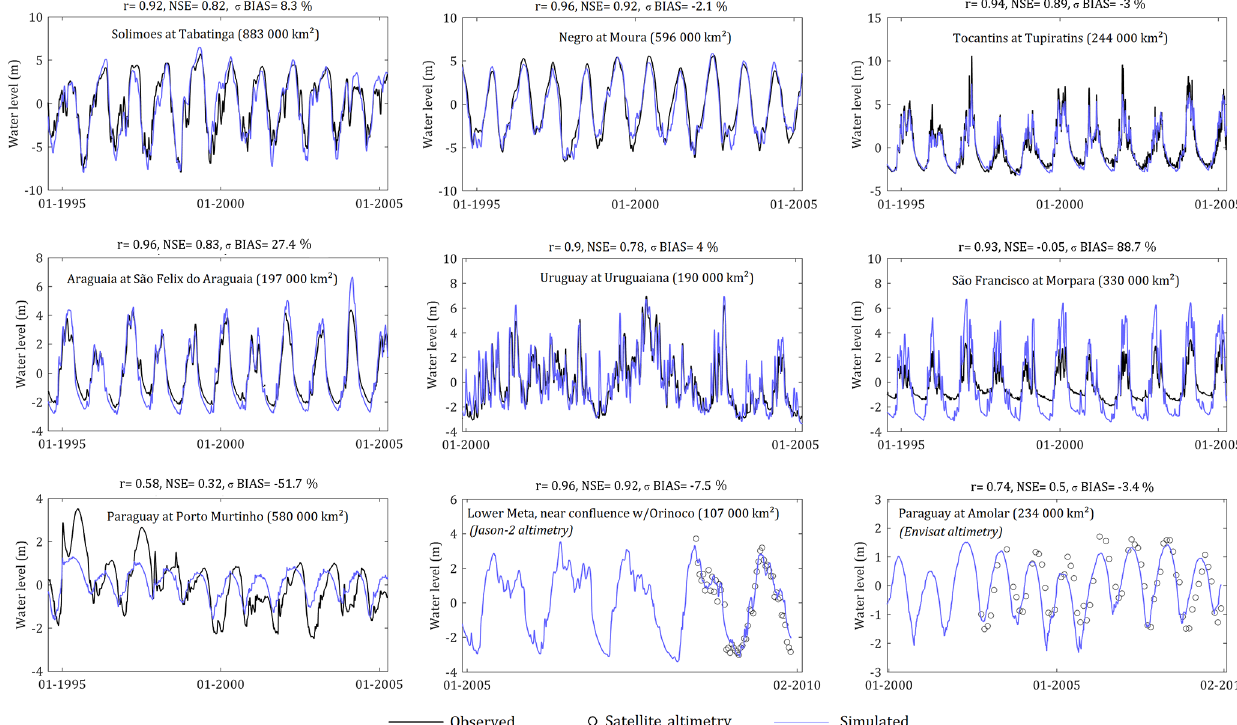
Figure 6. Comparison between simulated (blue) and observed (black) water level anomalies in major South American rivers for in situ gauges (continuous lines) and satellite altimetry (circles) at virtual stations